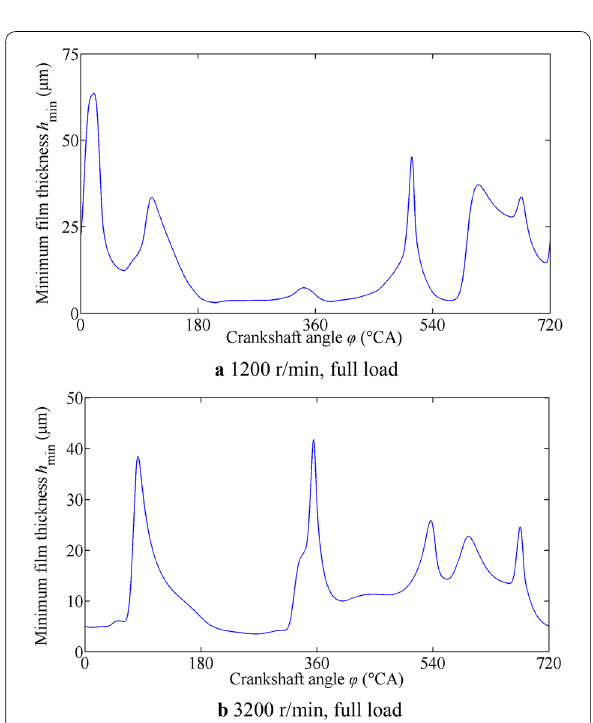
Figure 10 Minimum oil film thickness of No. 2 main bearing